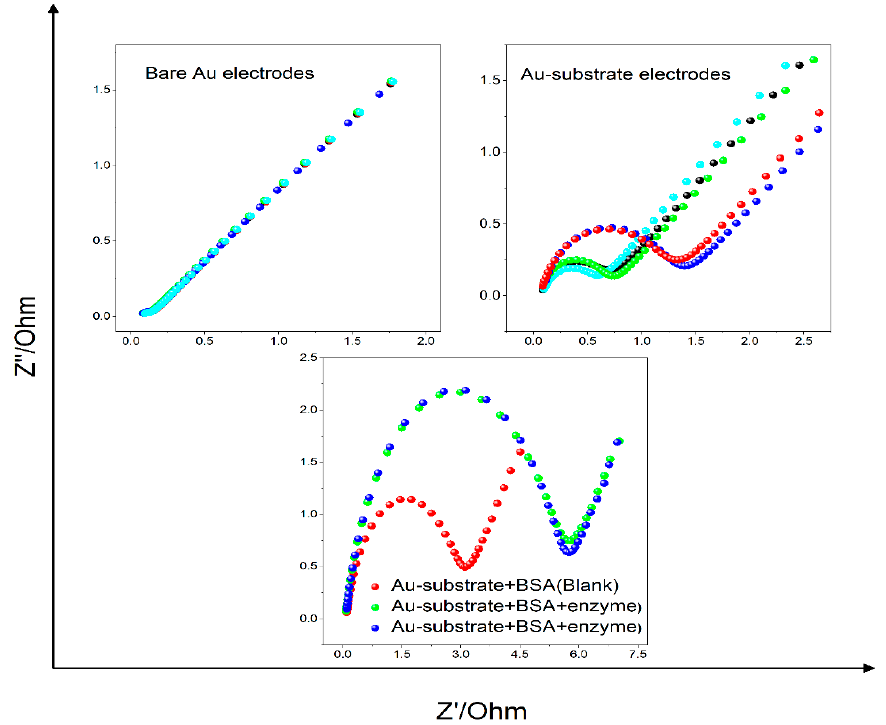
Figure 7. Nyquist plots of individual electrodes—bare, modified with substrate and after incubation with the enzyme (plus blank).